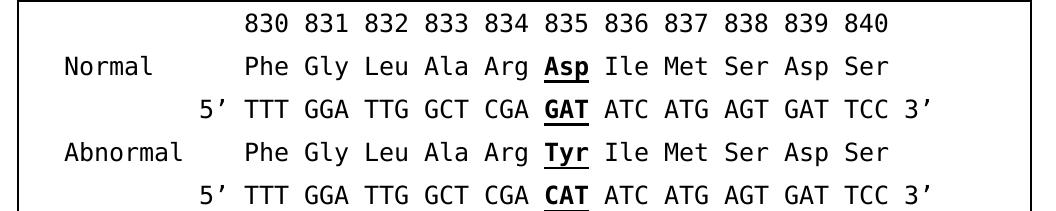
Figure 4. Point mutation in exon 20 of FLT 3 gene in AML cases detected by direct DNA sequence analysis. Mutated nucleotides are represented by changed amino acid, (bold).